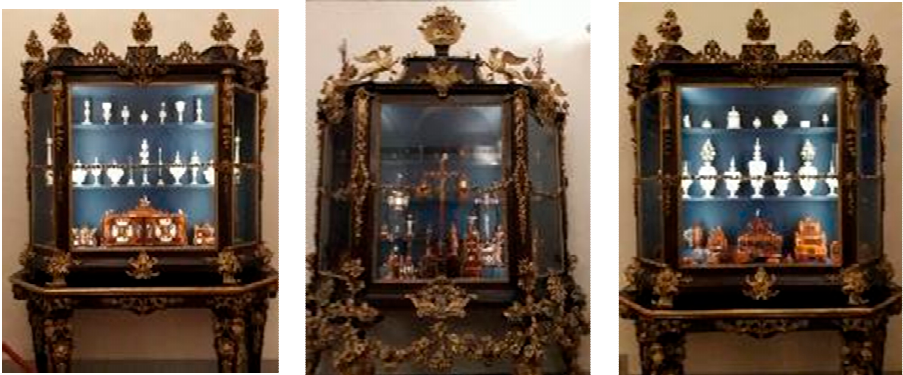
Figure 6. View of cabinets containing amber and ivory objects from the Medici collections with Kazimierz reliquary on far left bottom shelf. Palazzo Pitti (Tesoro dei Granduchi), Florence. Photos by the author.